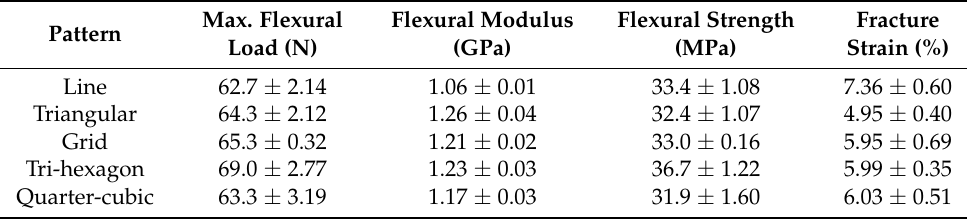
Figure 10. ( a ) In-plane force-extension; ( b ) stress–strain behavior of different infill patterns; ( c ) com- parison of in-plane flexural strengths for different infill patterns. Table 4. Experimental results for in-plane flexural properties at different infill patterns.